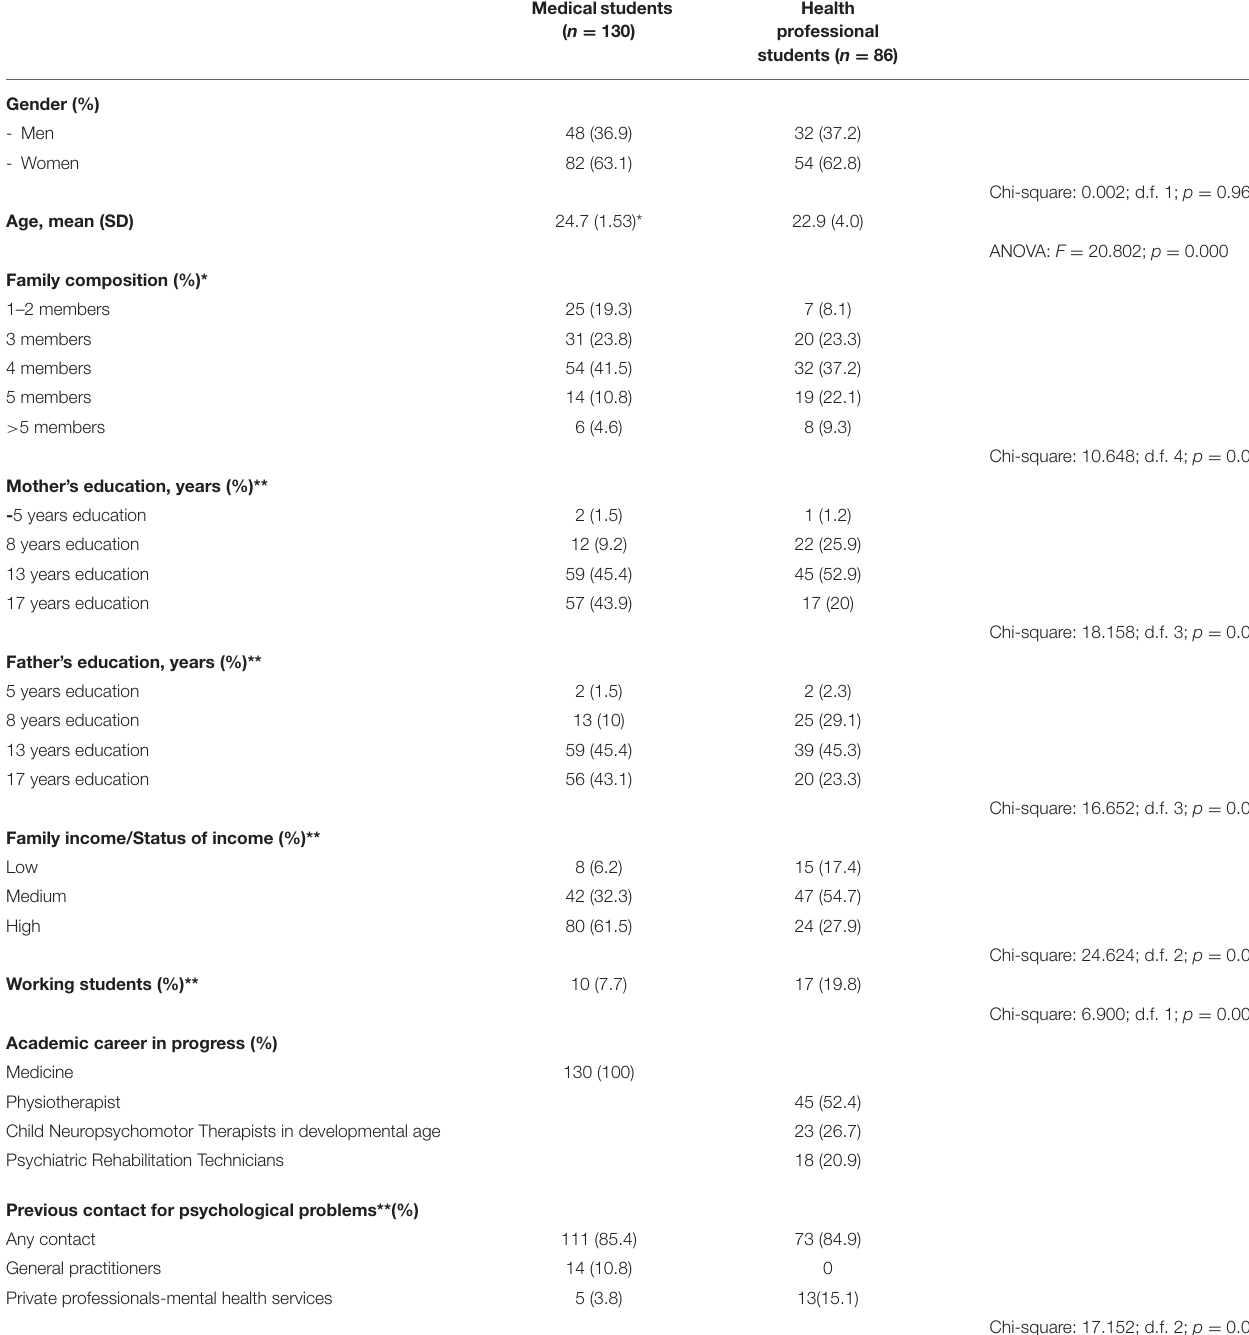
TABLE 2 | Socio-demographic and clinical characteristics of the sample ( n =